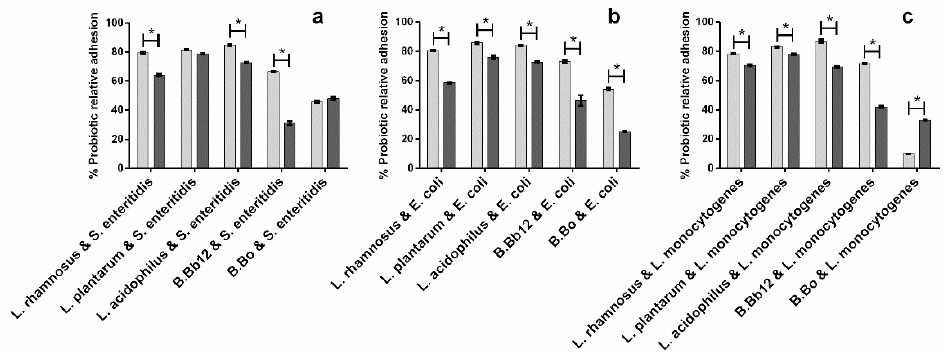
Figure 7. Impact of blueberry extract (presence ( (cid:4) ) and absence ( (cid:4) ) of extract) upon the probiotics relative adhesion in the exclusion assay for the pathogen/probiotic systems. ( a ) S. enteritidis /probiotic system, ( b ) E. coli /probiotic system, and ( c ) L. monocytogenes /probiotic system. The asterisks (*) mark statistically significant differences between sets of data ( p < 0.05).